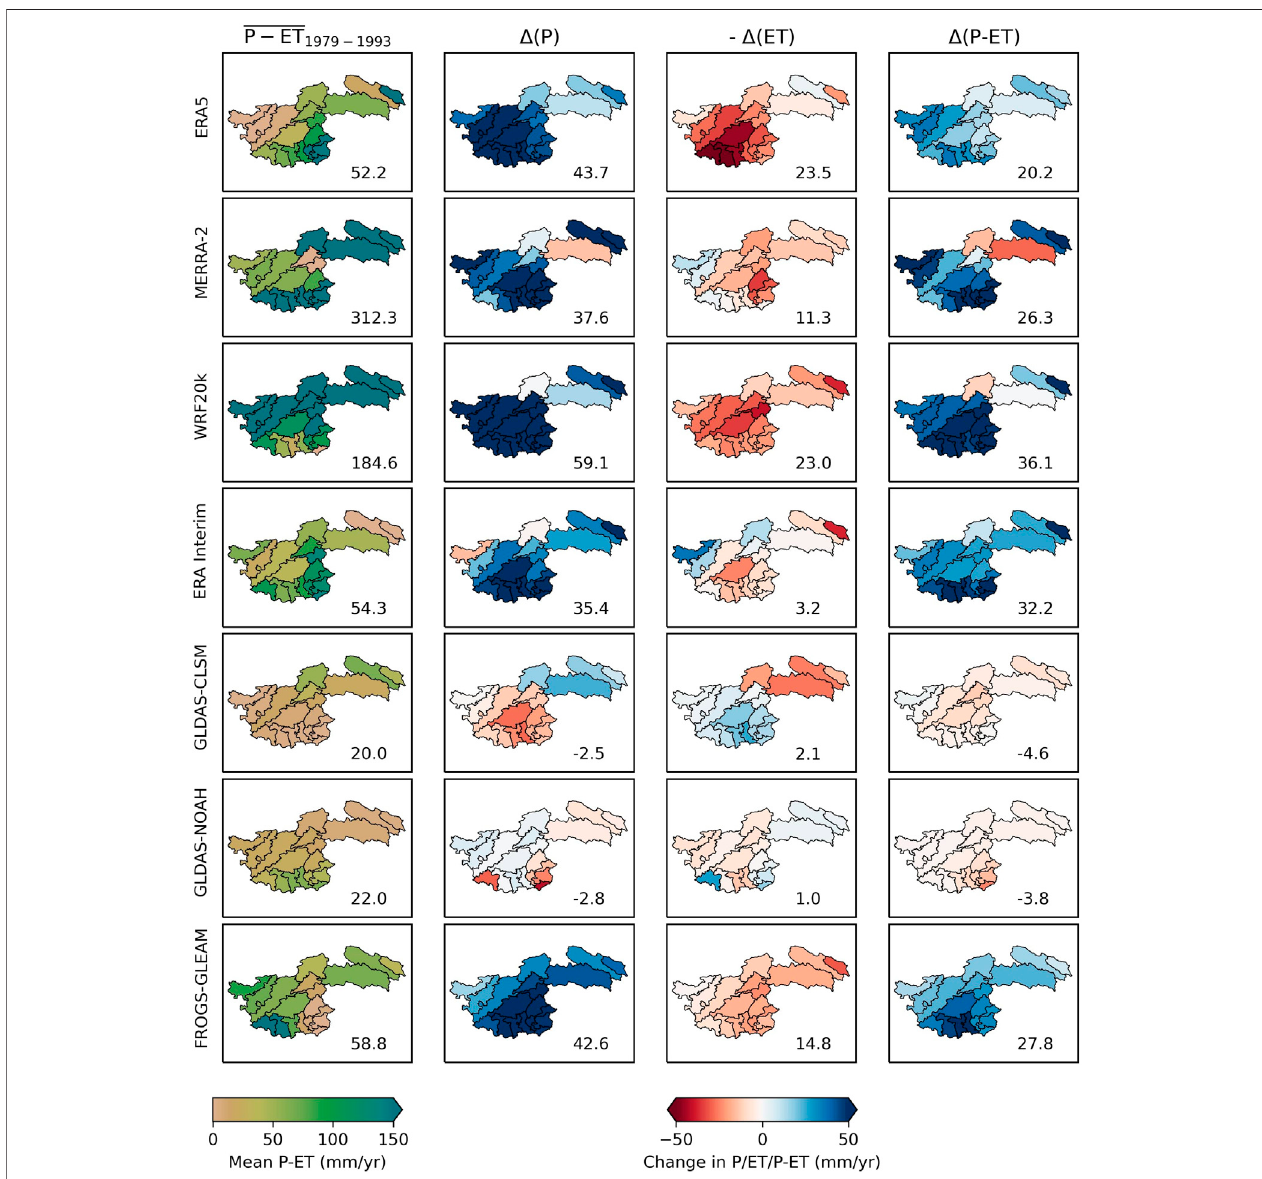
FIGURE 6 | Mean (P-ET) for the period 1979 – 1993 for each reanalysis product. Δ (P), − Δ (ET) and Δ (P-ET) are calculated as the annual mean differences for the period 1994 – 2015 relative to the period 1979 – 1993 (with the exception of WRF20k, which ends in 2010, and the GLDAS reanalysis which end in 2014). The FROGS- GLEAM data correspond to P from FROGS and ET from GLEAM. The numbers correspond to the area-weighted averages.